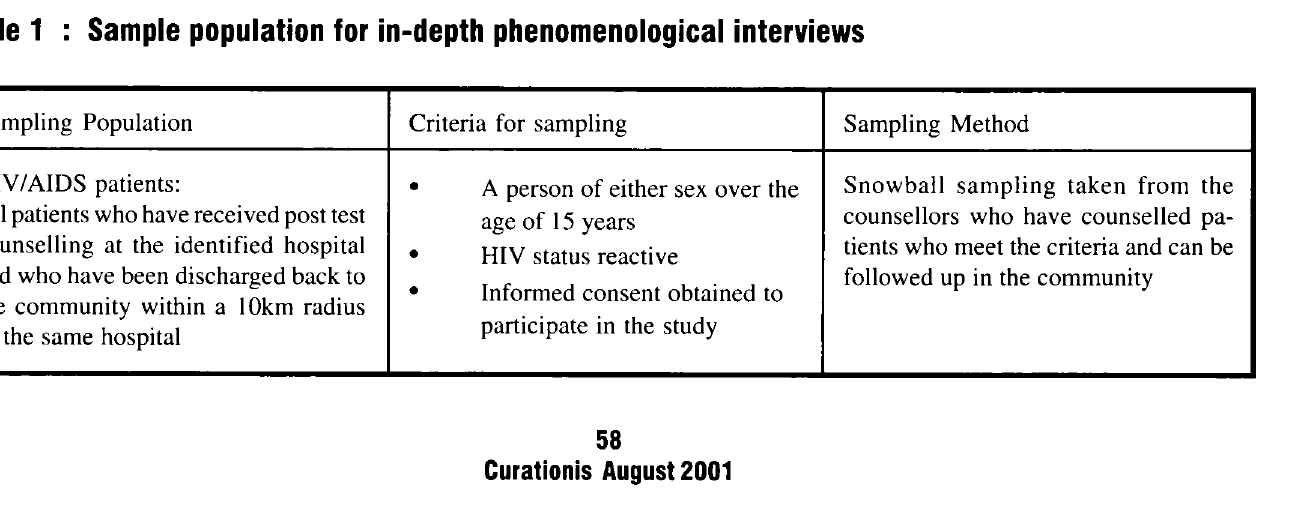
Table 1 : Sample population for in-depth phenomenological interviews